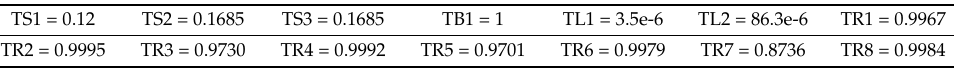
Table 4. Thresholds used in the